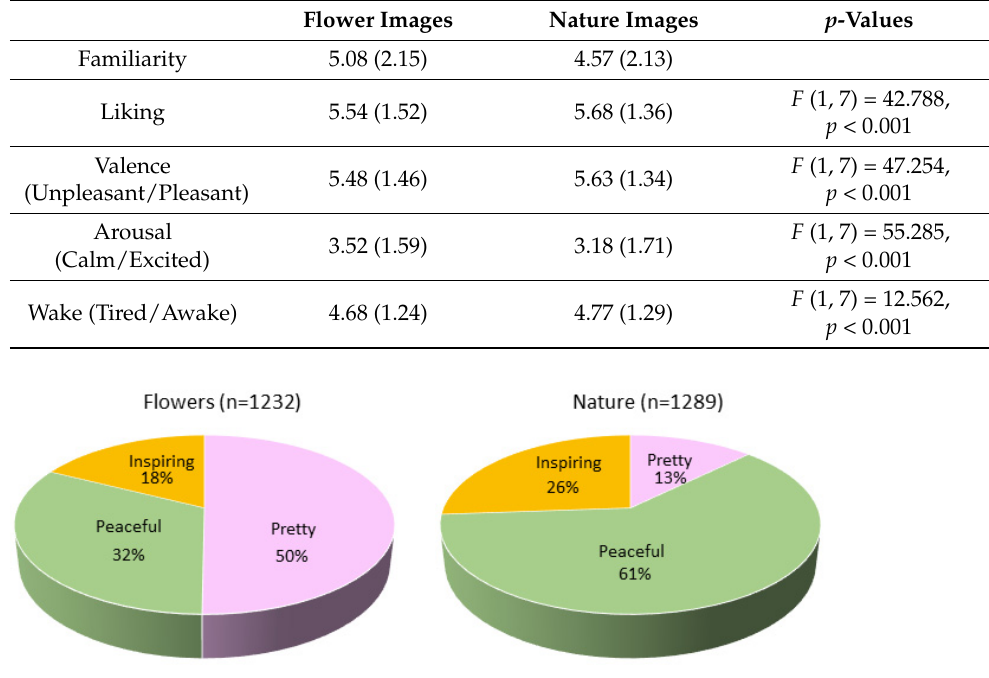
Table 1. Mean scores (on the 1 to 7 scale) and Standard Deviations (in parentheses) for the flower and nature images (see Figure 1). Familarity is used as a covariate for each other item. Flower Images Nature Images p -Values